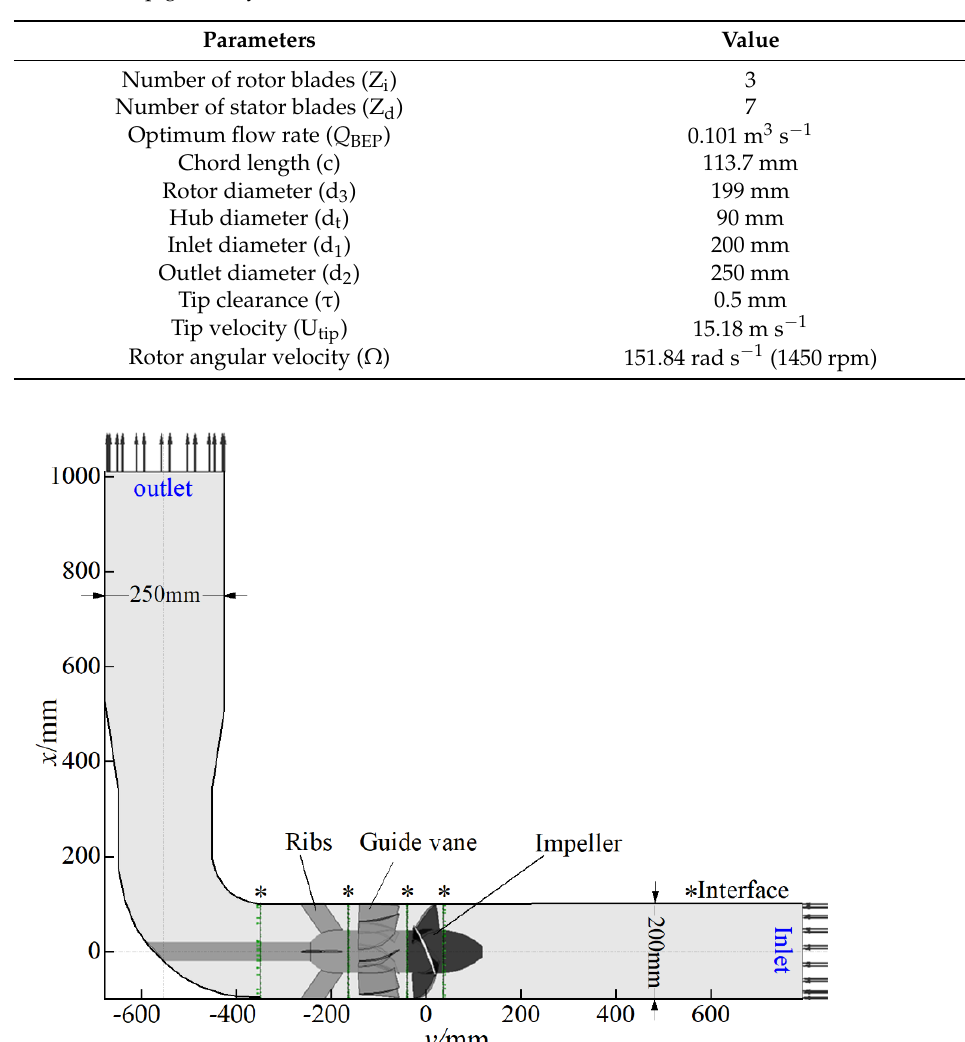
Figure 1. Axial flow pump computational domains.